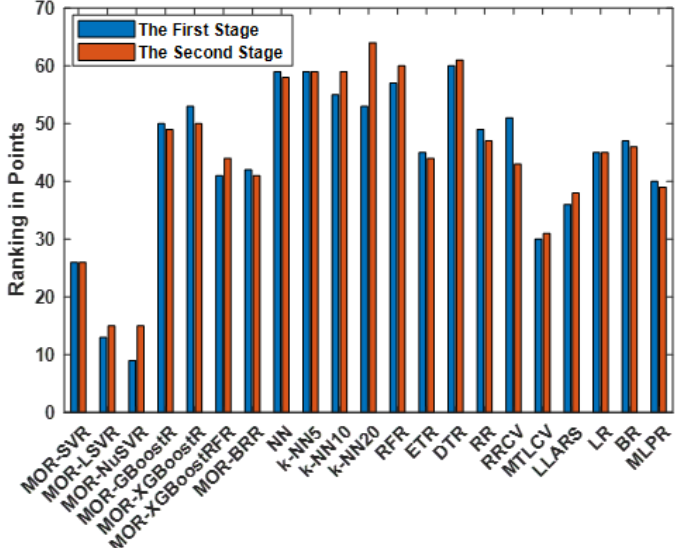
Figure 13. Overall ranking (in points) of all methods using the average values of their performance metrics (i.e., TT , PS , R 2 , and MSE ) over 50 statistical